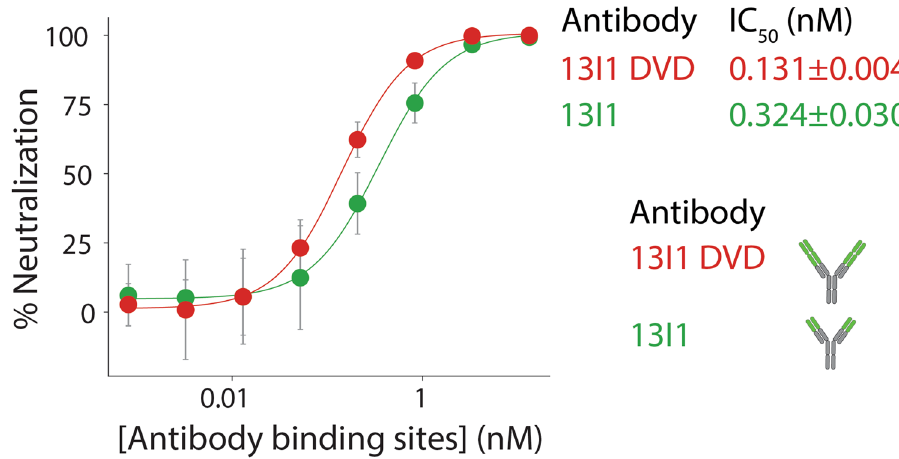
Figure 7. Increased valency enhances 13I1 neutralizing activity. Neutralizing activity of tetravalent 13I1 DVD-formatted antibody is shown relative to 13I1 bivalent antibody. A lentivirus-based SARS-CoV-2 pseudovirus assay was employed, and the relative luciferase signal was measured 48 h post infection. Calculated half-maximal inhibitory doses (IC 50 ) are presented. 13I1 DVD neutralizing activity was evaluated in parallel with 13I1 data collected in Fig. 5 and is shown here for clarity. These data are averages of three independent repeats, and the error bars are standard